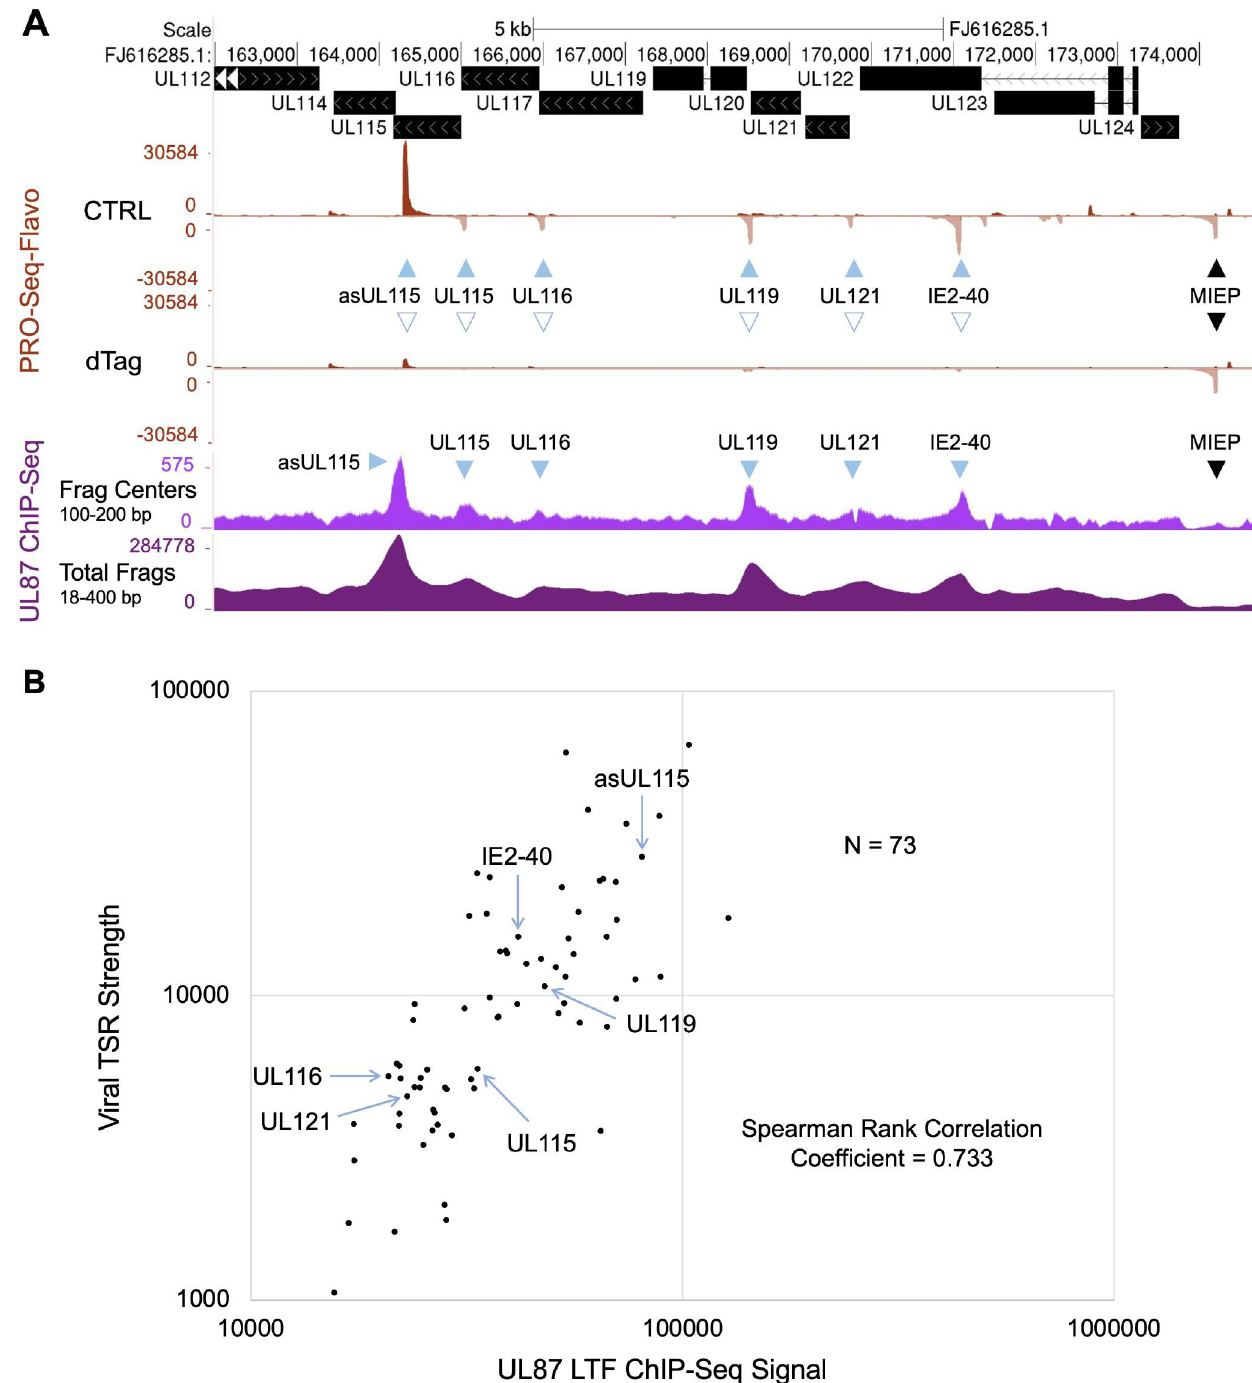
Fig 9. Relationship of promoter TSR strength and occupancy by UL87 LTF at 72 hpi. ( A ) UCSC Genome browser view of the distribution of the midpoints (centers) of UL87 LTF ChIP-Seq fragments of 100–200 bp in length (Frag Centers) mapped to the HCMV Towne MIEP and downstream promoters. This is compared to the distribution map of all UL87 LTF ChIP-Seq fragments (Total Frags), which range in length from 18 to 400 bp. PRO-Seq- Flavo analyses of vehicle CTRL vs. dTag treatment for the final 6 h of the infection reveal locations and sizes of UL87 LTF-responsive and -unresponsive promoter TSRs. Blue arrows point to LTF-responsive viral promoter TSRs with corresponding UL87 LTF ChIP-Seq peaks that have > 15000 ChIP-Seq Frag Centers (in fragments of 100–200 bp length) located within a 200 bp window centered on base position -25 relative to the MAXTSS for the TSR. Black arrow denotes location of the LTF-unresponsive MIE promoter TSR. ( B ) Scatterplot shows the relationship of UL87 LTF ChIP-Seq signal and TSR strength. The Frag Center count within the 200 bp window described above represents the number of signals in the UL87 LTF ChIP-Seq peak. TSR strength is the number